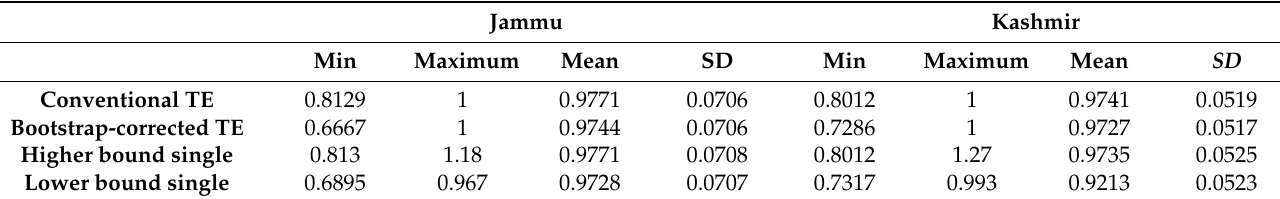
Table 5. Conventional DEA and bootstrap TE